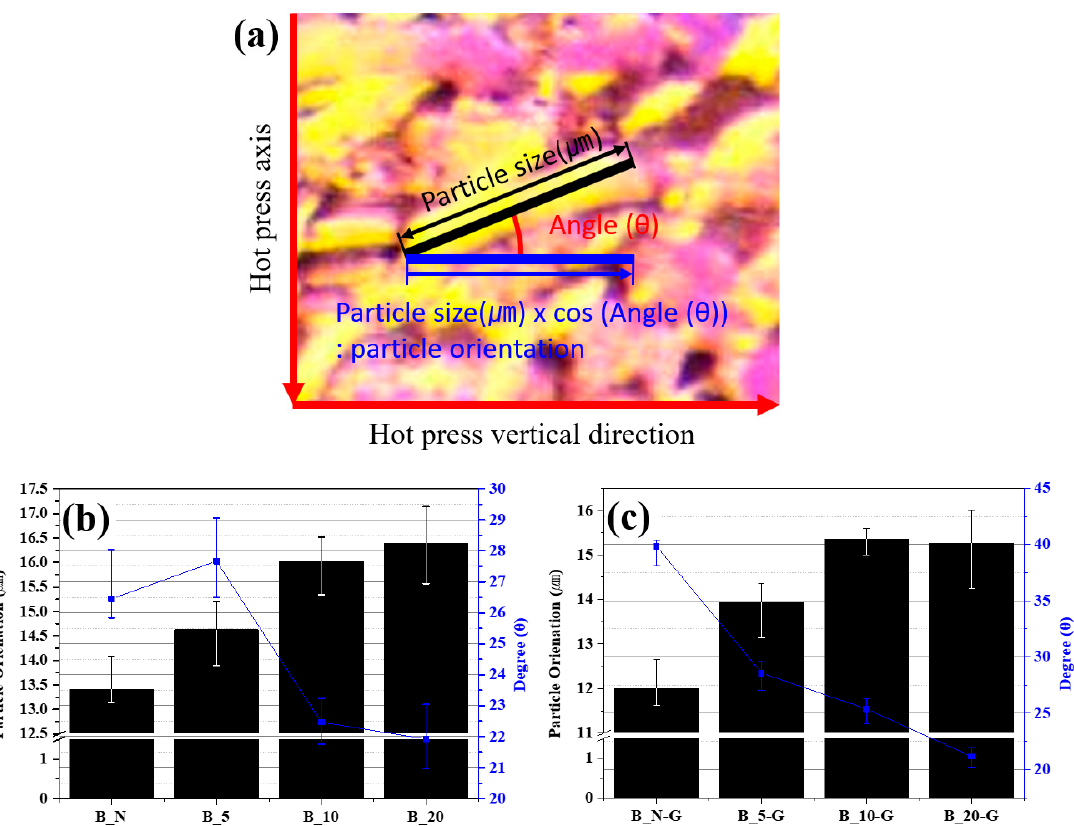
Figure 4. Particle orientation: ( a ) measure method of particle orientation; ( b ) particle orientation of green block and ( c ) graphite block.